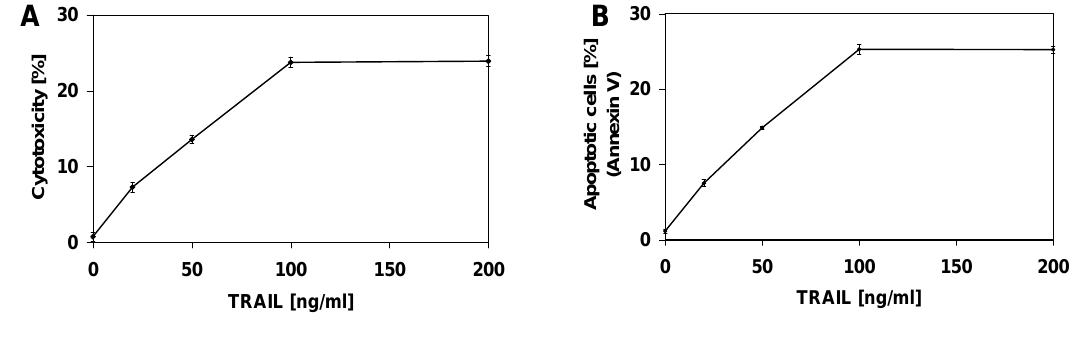
Figure 3. Cytotoxic and apoptotic effect of TRAIL on LNCaP prostate cancer cells. The cancer cells were incubated for 48 hours with TRAIL at the concentrations of 20–200 ng/mL. The values represent mean ± SD of three independent experiments performed in quadruplicate (n = 12) for cytototoxicity, or in duplicate (n = 6) for apoptosis (p < 0.05). (A) Cytotoxic activity of TRAIL in LNCaP cells. The percentage of cell death was measured by MTT cytotoxicity assay. (B) TRAIL-induced apoptosis in LNCaP cells. Detection of apoptotic cell death by annexin V-FITC staining using flow cytometry.